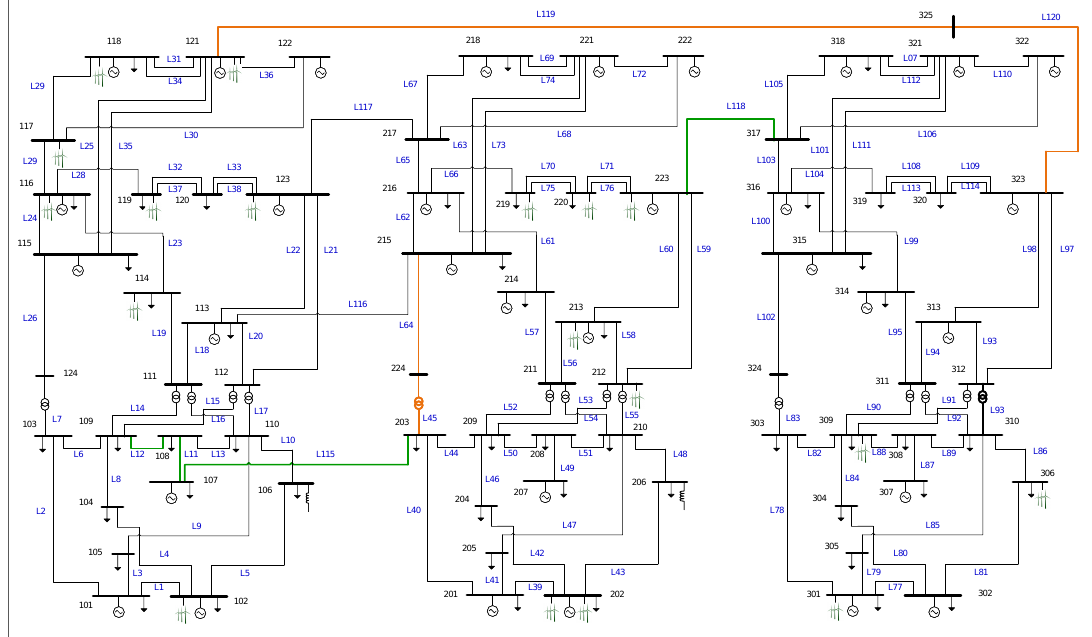
Figure 1. Test system under study (IEEE